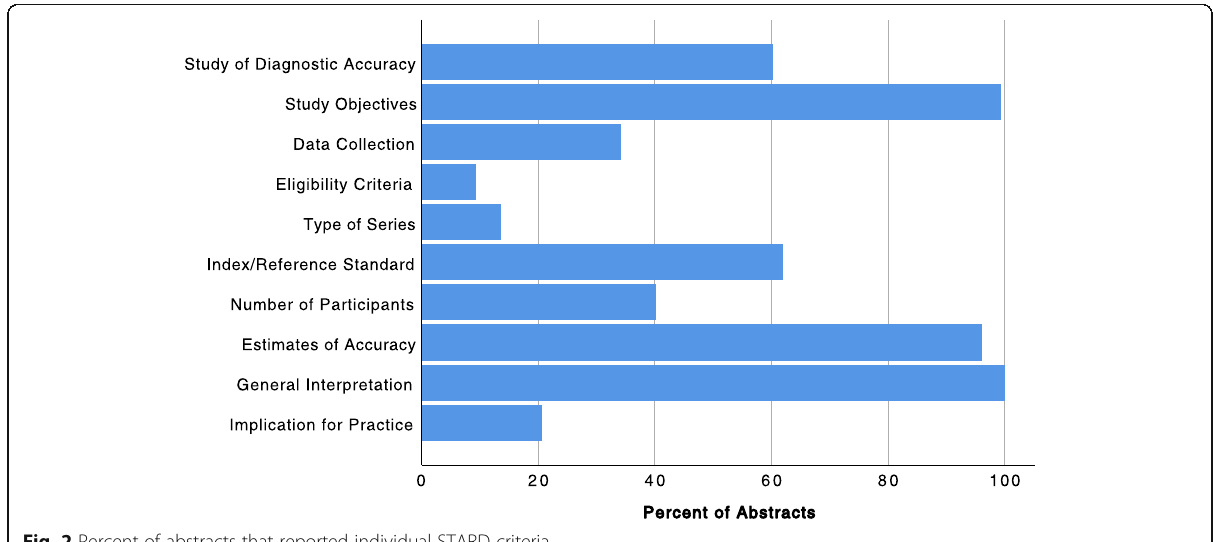
Fig. 2 Percent of abstracts that reported individual STARD